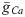
Assessing the dependence of fres and QZ of the intermediate g¯Ca models on the linear g¯Ca−g¯H correlation.a. Parameter values for each model were in the intermediate g¯Ca group (see Fig 7) were changed along a line parallel (‖, blue) to the correlation line (black) or along a perpendicular line (┴, grey). For each model and each line, ‖ or ┴, we fit a line to the relative change in either fres or QZ as a function of the relative change in g¯Ca. b. The sensitivity values of fres or QZ to ‖ or ┴ are shown for the three groups. c. Impedance profiles showing how QZ changes when the parameters vary along a line parallel (blue) or perpendicular (grey) to the g¯Ca−g¯H correlation line in one optimal model. Arrows show the direction of the movement of Zmax and fres for the change in parameters along ‖ or ┴.